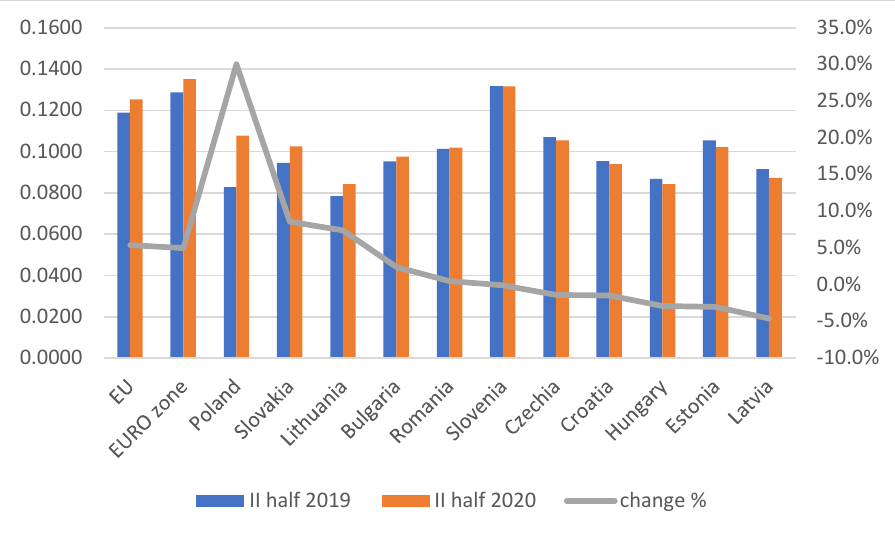
Figure 2. Changes in non-household electricity prices in the second half of 2019, compared with the second half of 2019 (EUR per kWh). Poland in comparison to selected European countries.